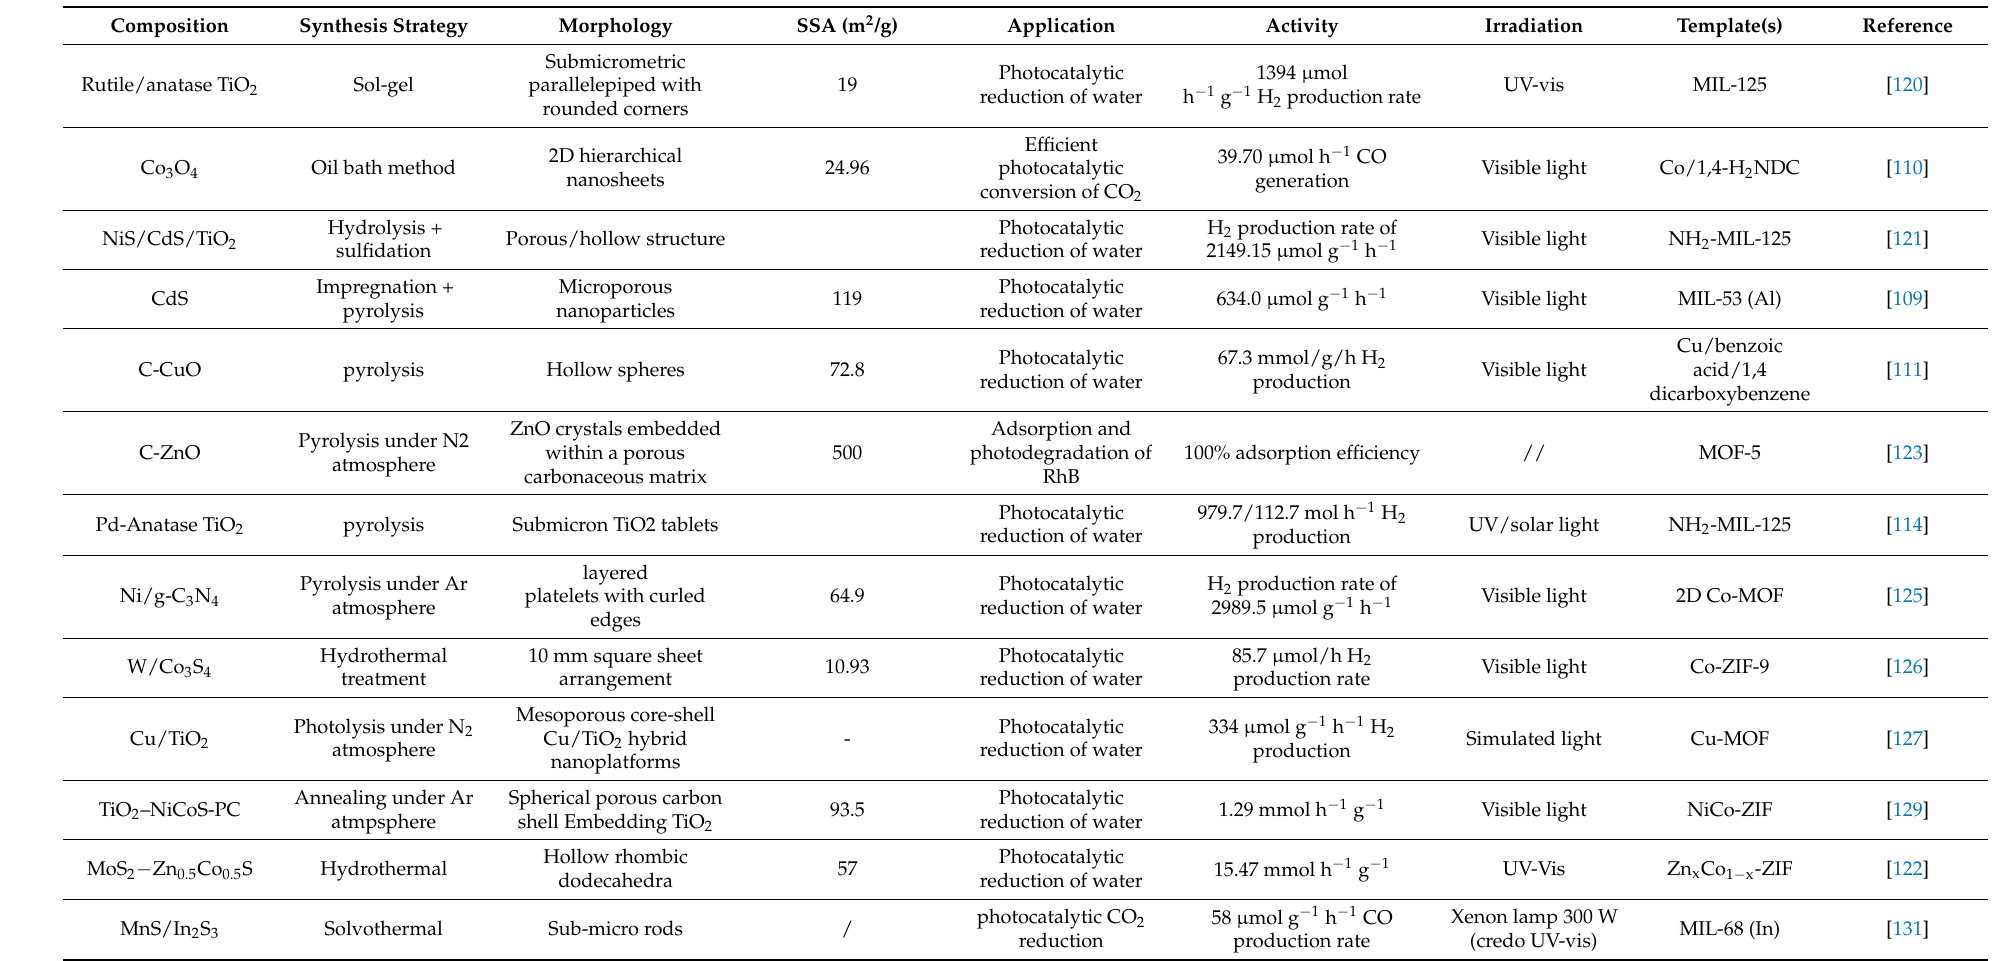
Table 4. Hierarchical catalysts produced by using hybrid